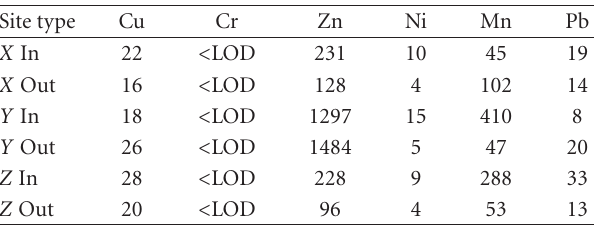
Table 11: Concentrations ( µ g/L) of metals in sewage influent and e ffl